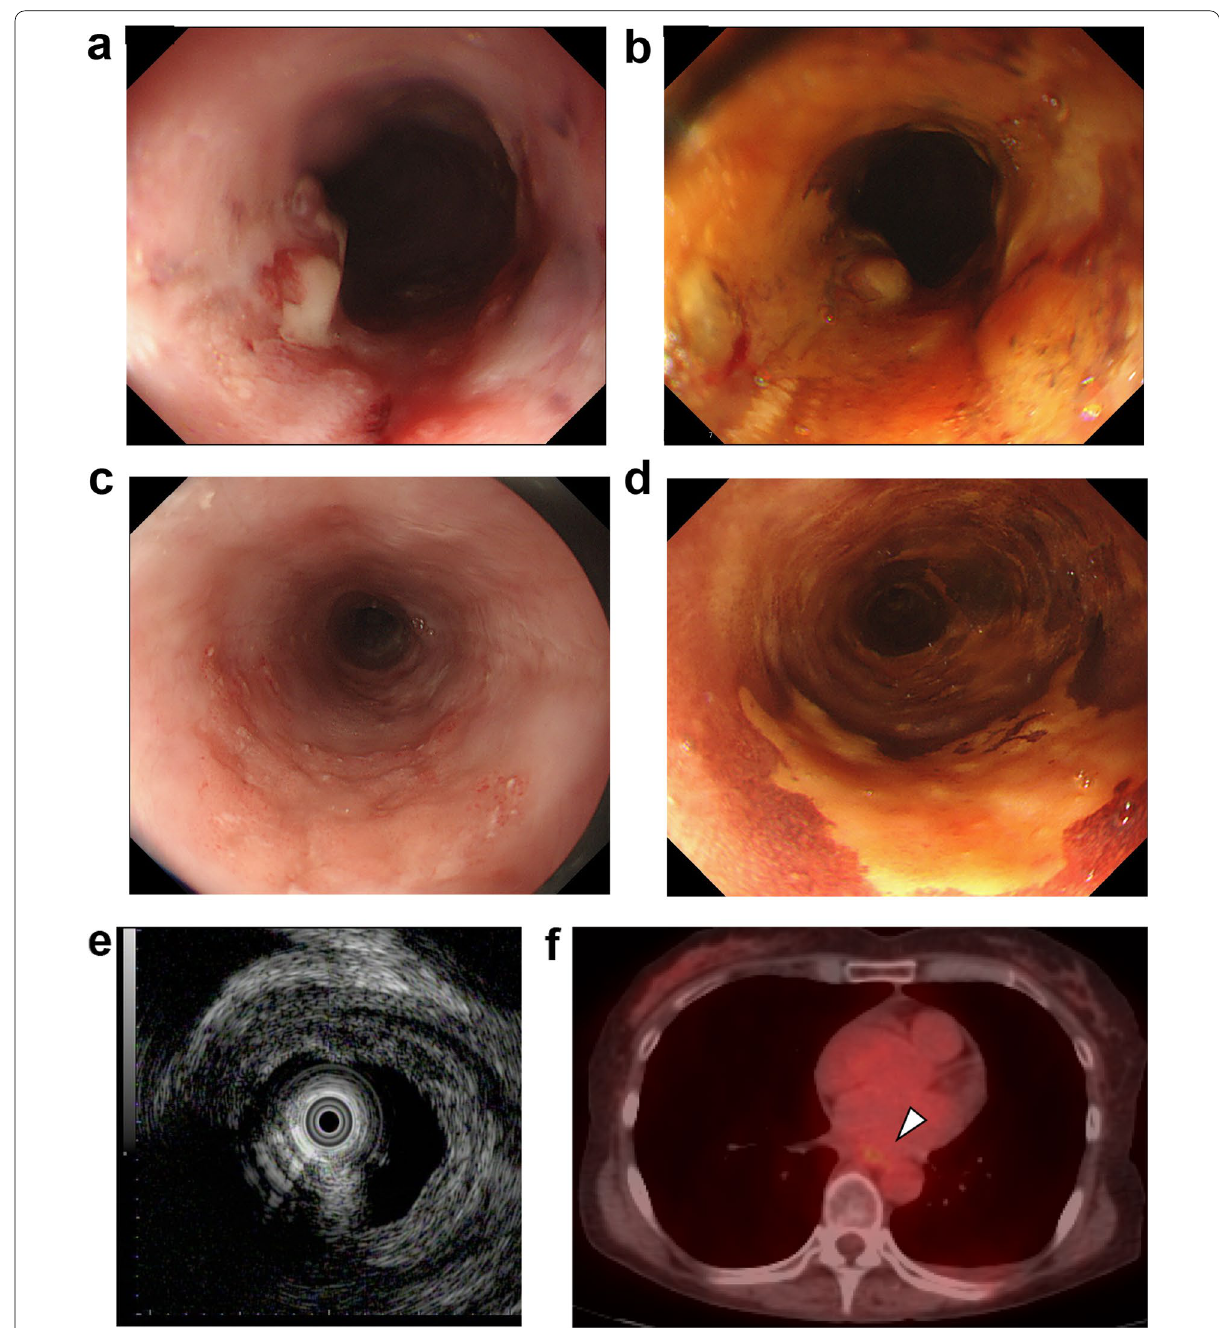
Fig. 2 Findings prior to salvage surgery. a – d Upper gastrointestinal endoscopy 6 years after carbon-ion radiotherapy. An elevated lesion at the previously treated area (27–29 cm from the incisors) was detected by a white light endoscopy and b Lugol staining. In addition, a type 0-IIa lesion located 20–22 cm from the incisors had freshly appeared. c White light endoscopy. d Lugol staining. e Ultrasound endoscopic finding. The tumor located 27–29 cm from the incisors was thought to have infiltrated the submucosal layer. f 18 F-deoxyglucose (FDG) positron emission tomography revealing slight FDG uptake in the middle esophagus (white